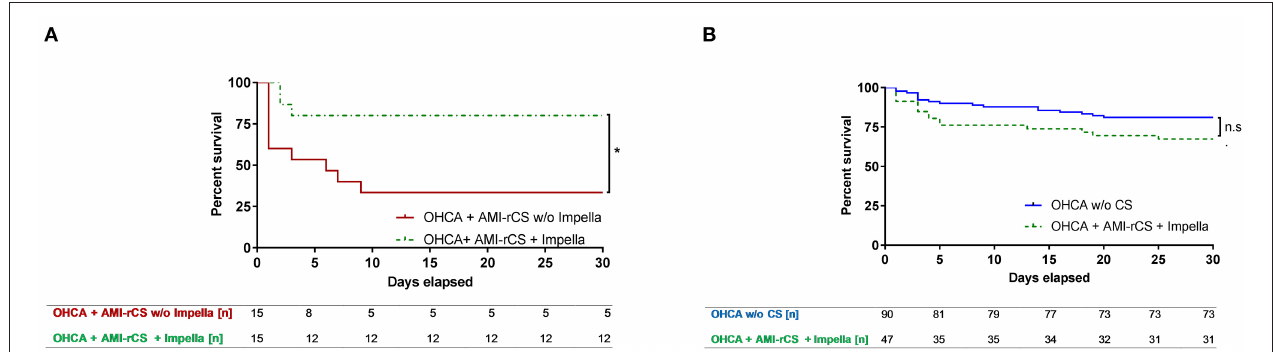
FIGURE 3 | 30-day survival after propensity score matching. AMI, acute myocardial infarction; CI, confidence interval; CS, cardiogenic shock; HR, hazard ratio; OHCA, out-of-hospital cardiac arrest; rCS, refractory cardiogenic shock. (A) Kaplan–Meier curves of AMI–rCS after OHCA with or without active left ventricular unloading by Impella, * p < 0.05. (B) Kaplan–Meier curves of AMI–rCS patients after OHCA without CS or with AMI–rCS supported by Impella.